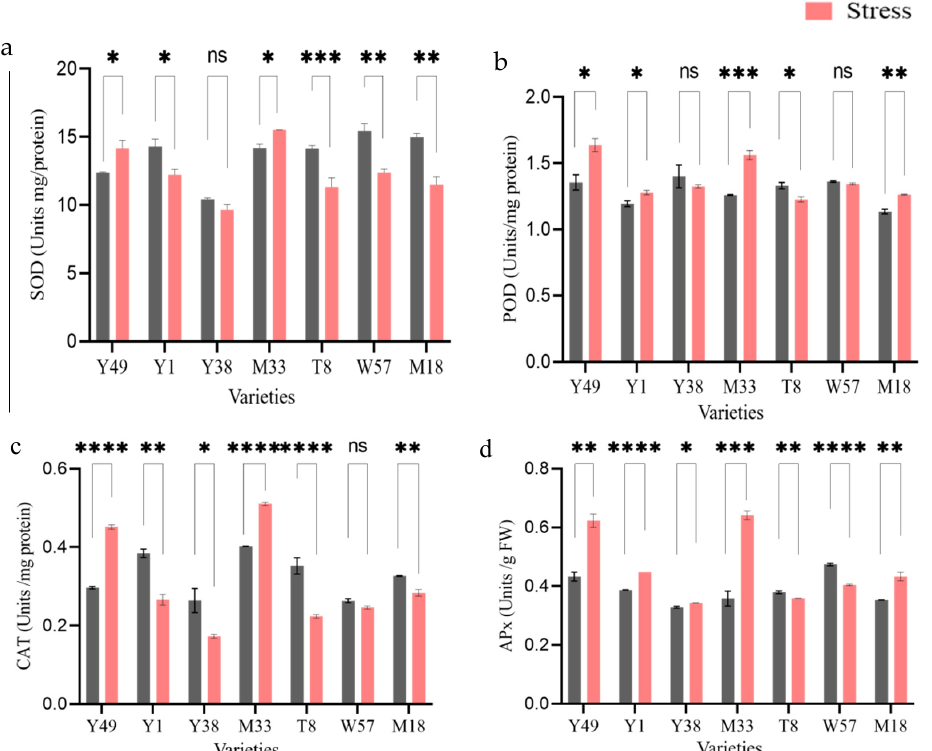
Figure 3. Influence of cold stress on leaf antioxidant and enzymatic antioxidants in jute varieties. Plants under control (28 °C) and stress (5 °C) showed a response in: ( a ) Superoxidase dismutase (SOD) activity, ( b ) Peroxidase (POD) activity ( c ) Catalase (CAT) activity and ( d ) APx activity. Different significant level marked with **** p < 0.0001, *** p ≤ 0.001, ** p ≤ 0.01, * p ≤ 0.05, and ns mean